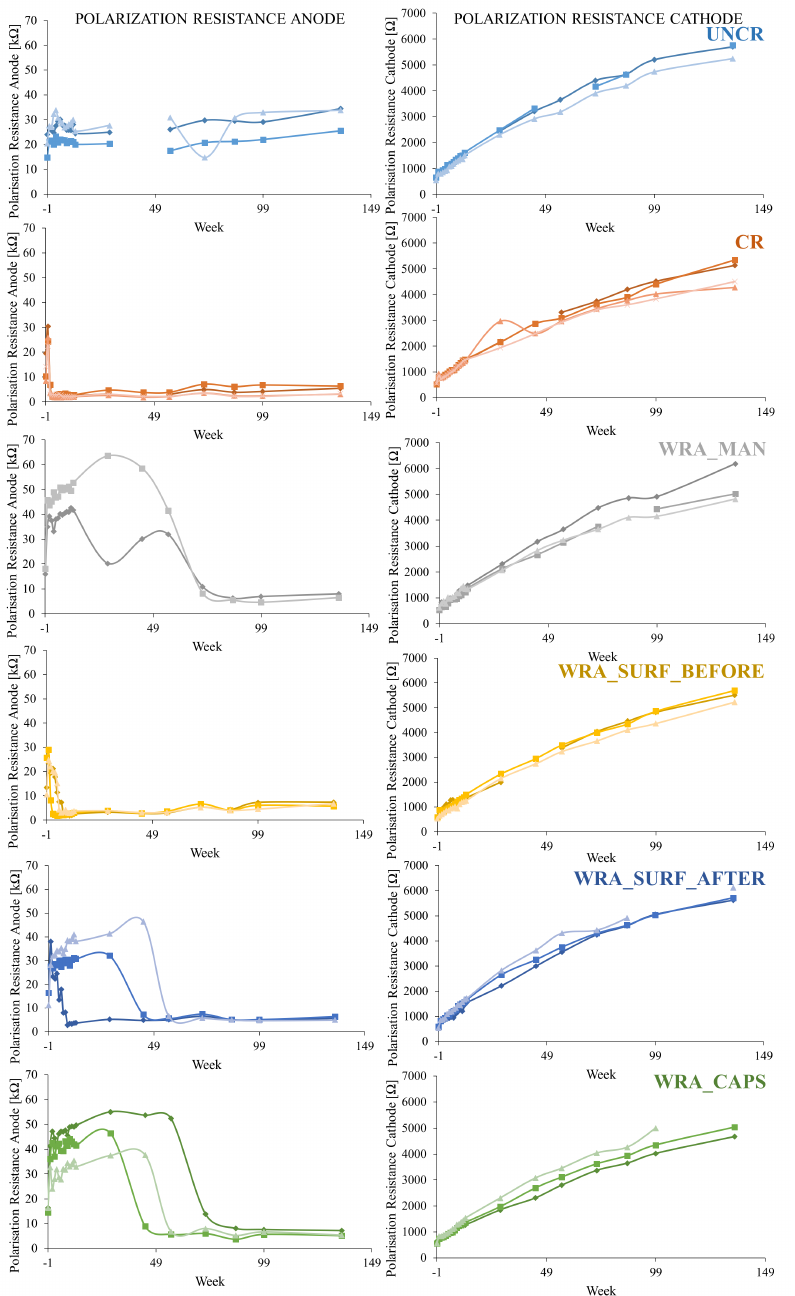
Figure 9. Evolution of the polarization resistance of the anode and cathode and the concrete resistance (polarization resistance anode for one sample of the WRA_MAN series is missing as the internal electrical connection with the anode was damaged during concrete casting, different shades of the colours are used to represent the repetitions per test